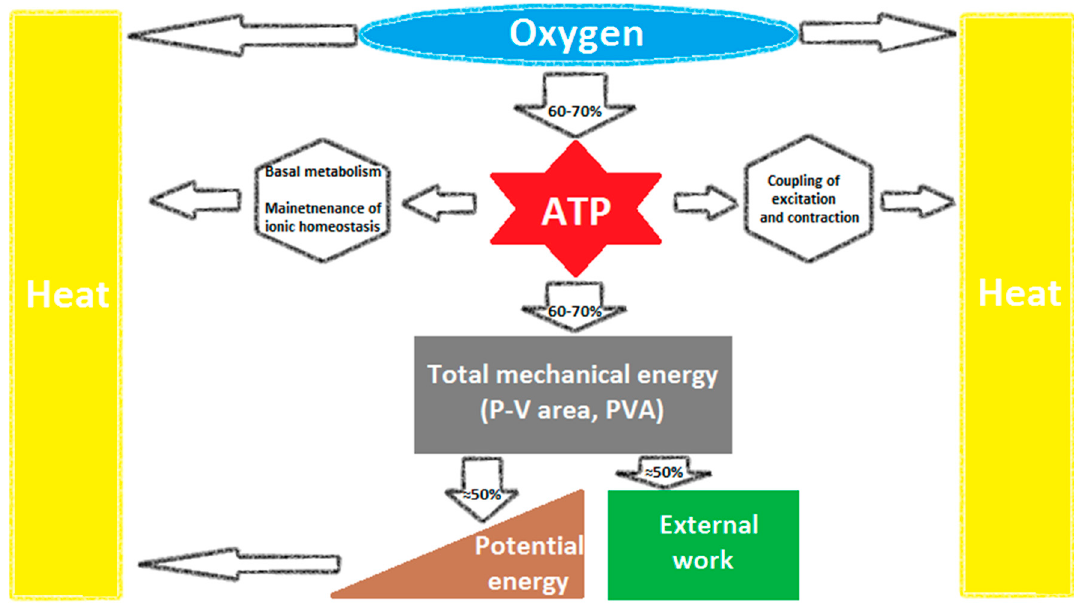
Figure 2. Multi-step energy transfer from myocardial oxygen consumption to external work (EW): 1—from oxygen consumption to ATP synthesis; 2—from ATP split to pressure–volume area (PVA) (reflecting total mechanical energy); 3—from PVA to EW [3]. ATP: adenosine triphosphate.